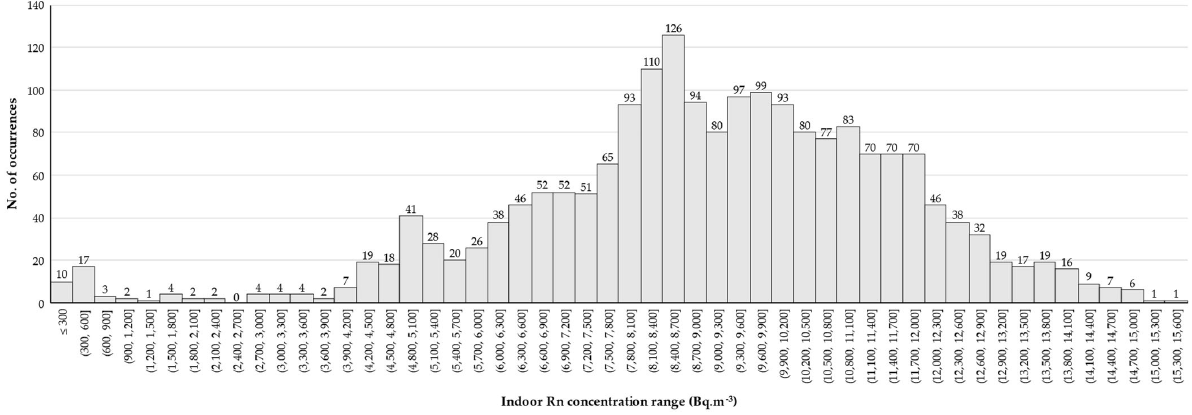
Figure 8. Distribution of indoor Rn concentration measurements in the compartment after sealing the door.